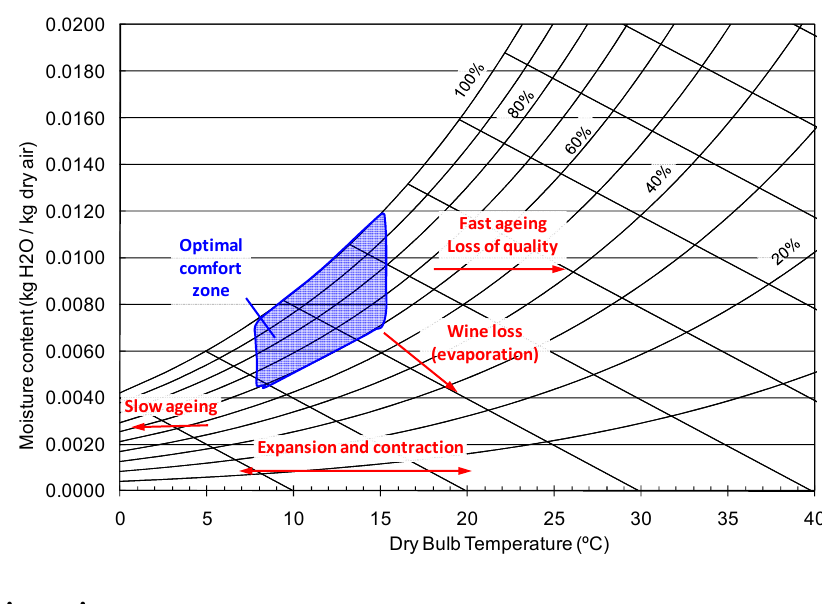
Figure 3. Recommended optimal comfort zone for wine aging and possible harmful effects outside this zone.